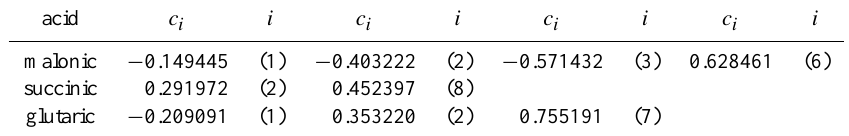
Table 4. Fitted parameters of Clegg and Seinfeld (2006a) for use with the empirical parameterization given in Appendix